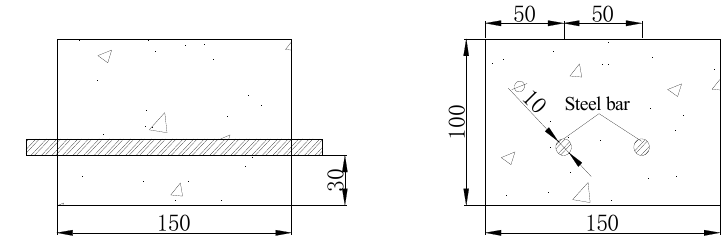
Table 2. Mixture proportions.